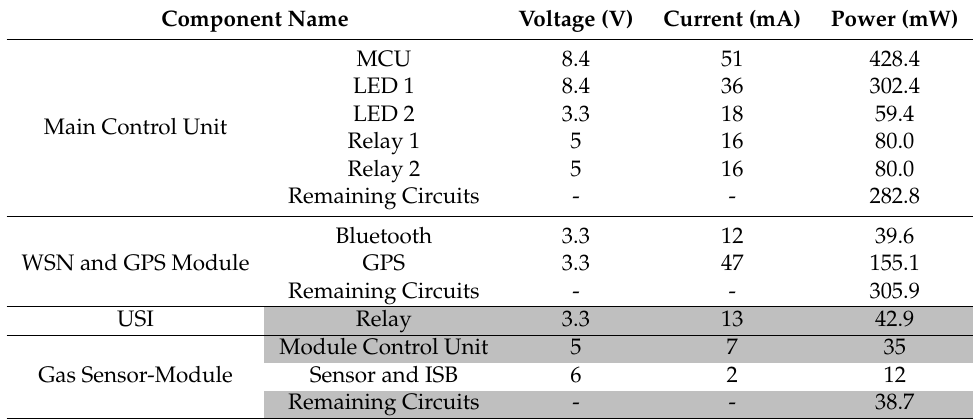
Table 3. Power consumption of each major component on the MSS sensor node. (MCU: micro-controller unit; LED: Light Emitting Diode; WSN: Wireless Sensor Network; GPS: Global Positioning System; USI: Universal Sensor Interface; ISB: Individual Sensor